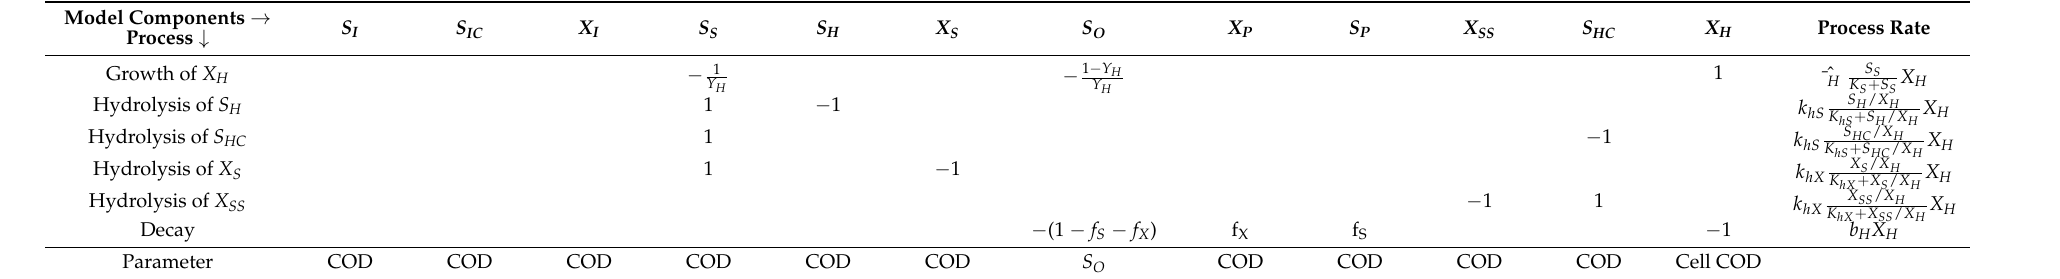
Table 1. Matrix representation of the proposed model,